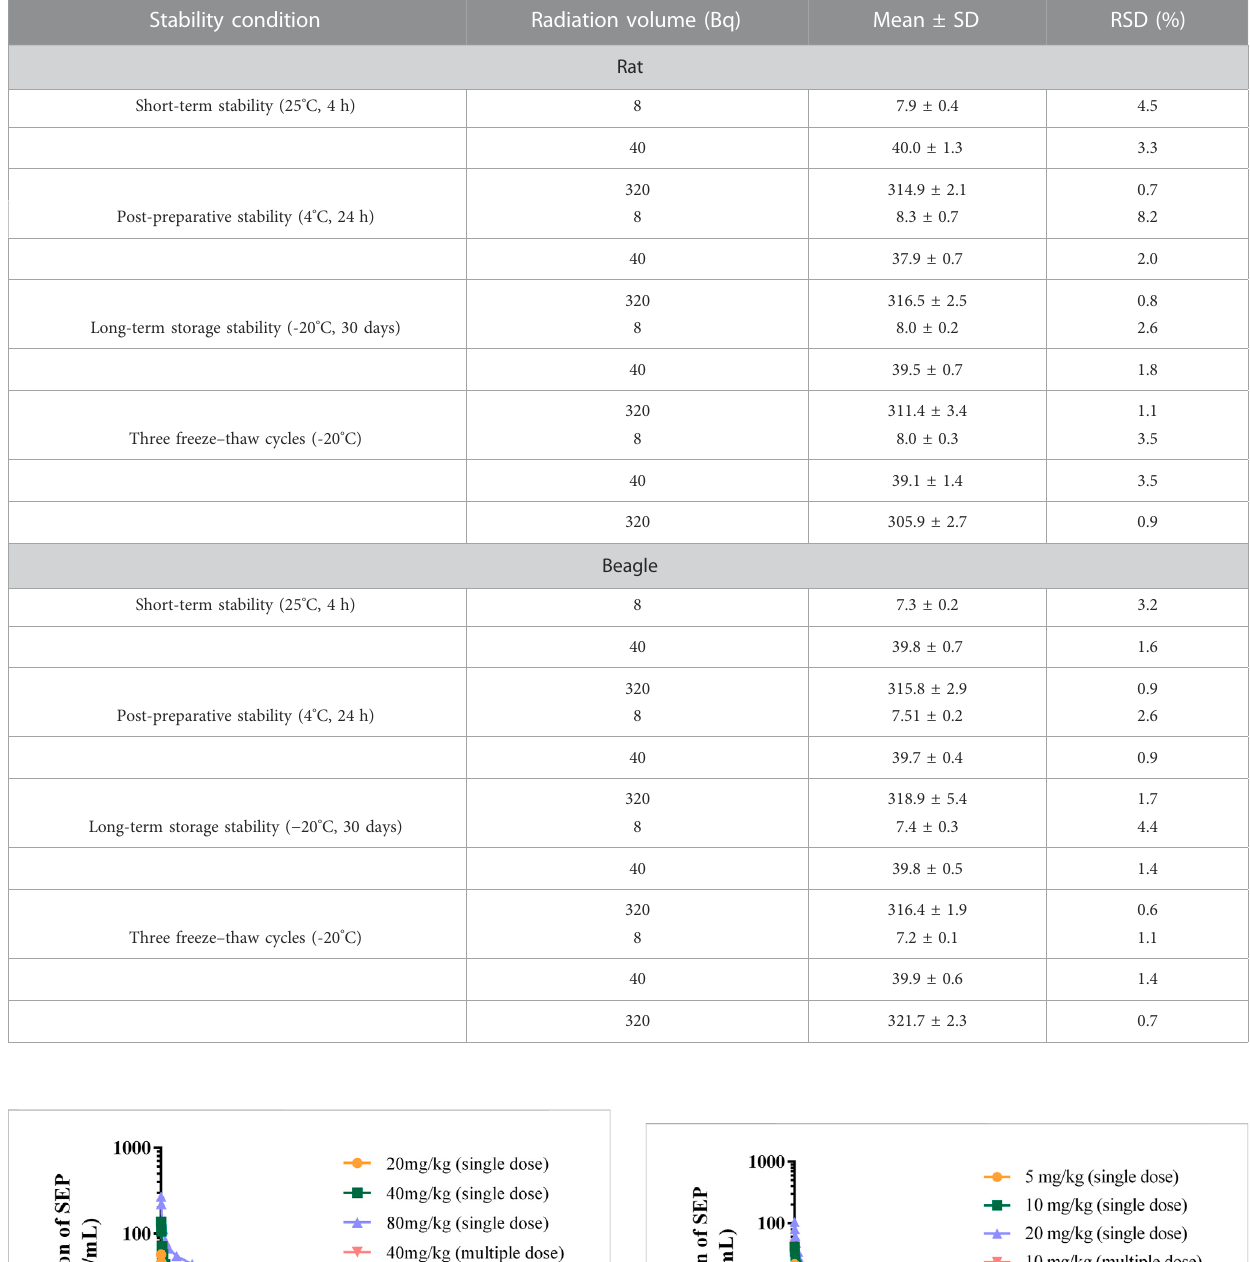
TABLE 2 Stability results for 3 H-SEP in rat and beagle plasma.